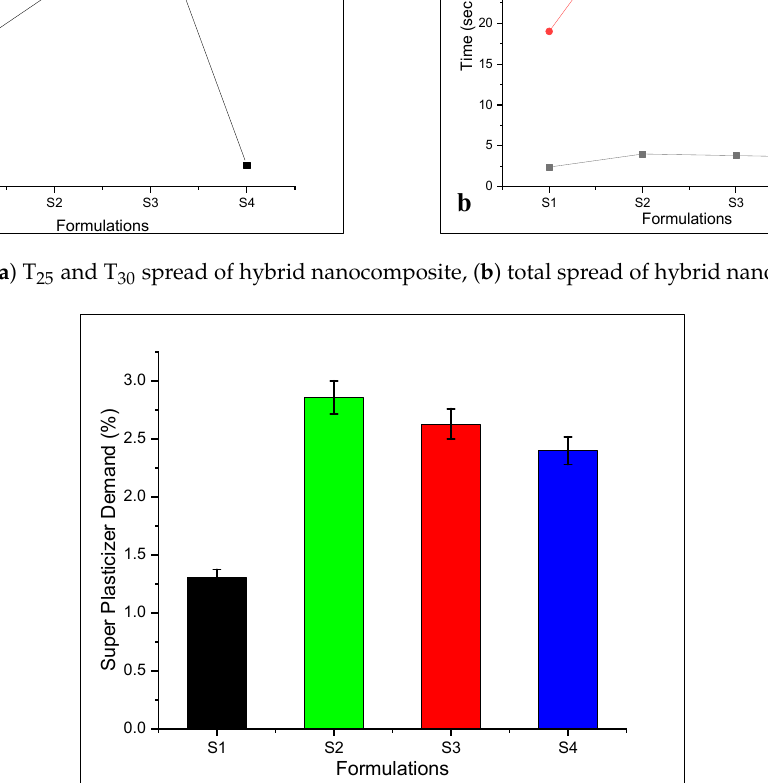
Figure 12. Superplasticizer demand of